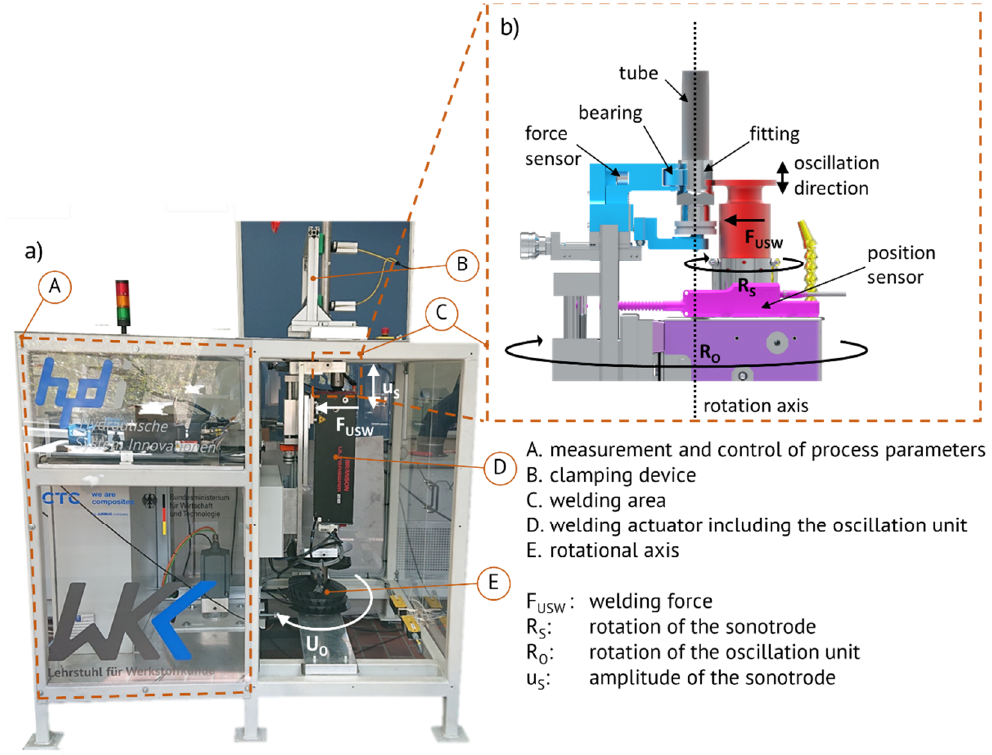
Figure 5. Orbital welding system for Ti/CFRP-tubes: ( a ) general overview and ( b ) reduced CAD model of the welding area.